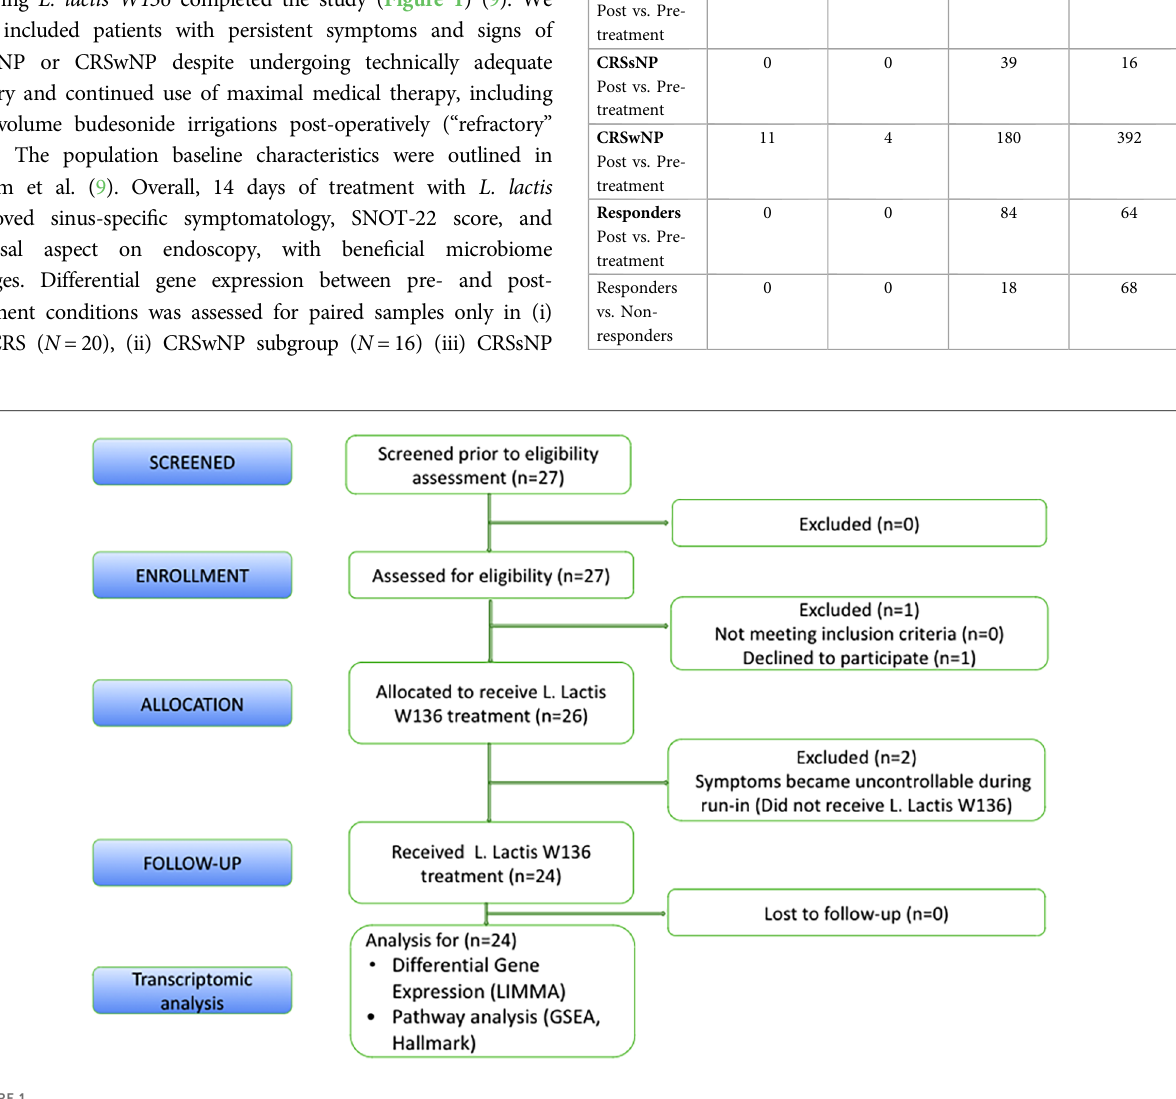
FIGURE 1 CONSORT